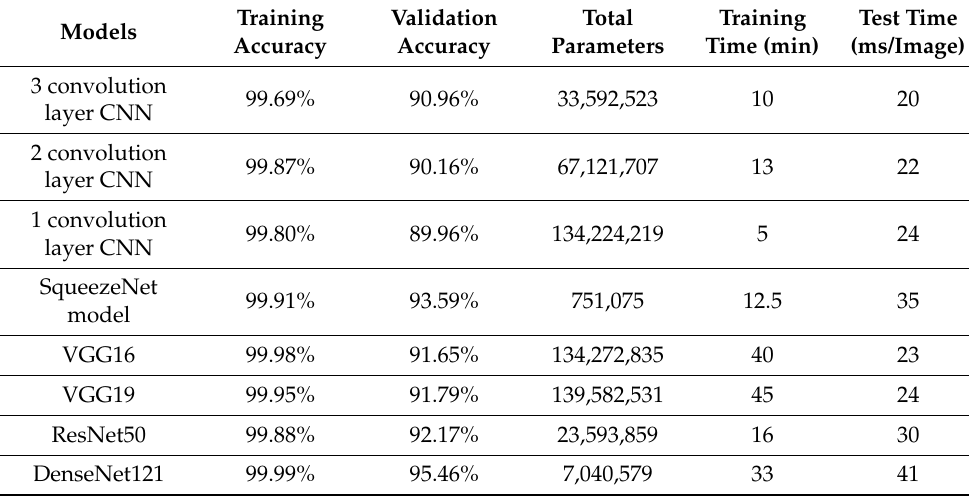
Table 3. Database without ambient